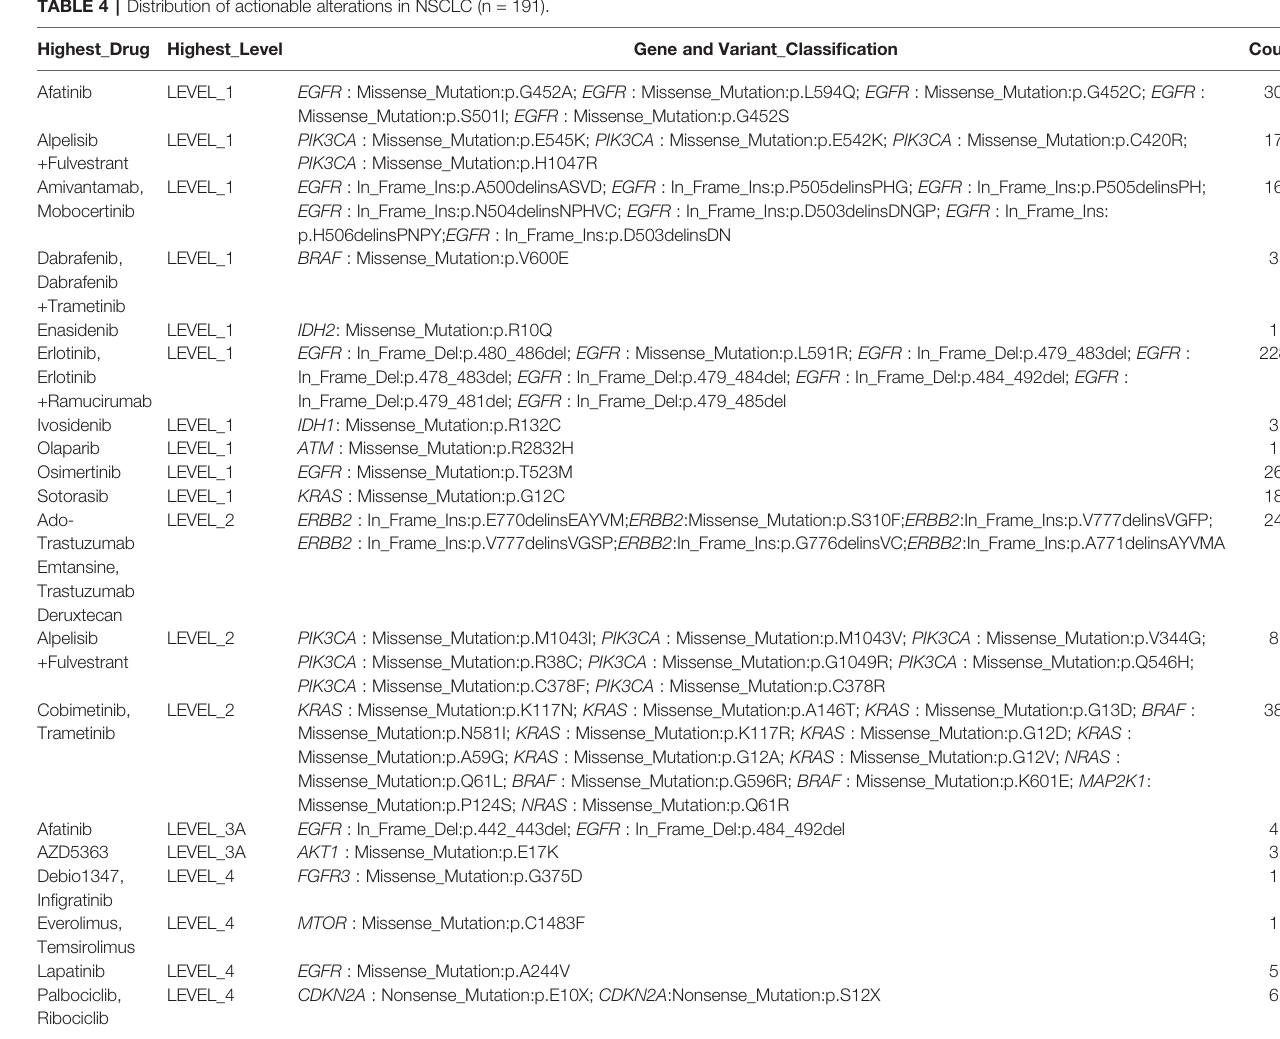
TABLE 4 | Distribution of actionable alterations in NSCLC (n =